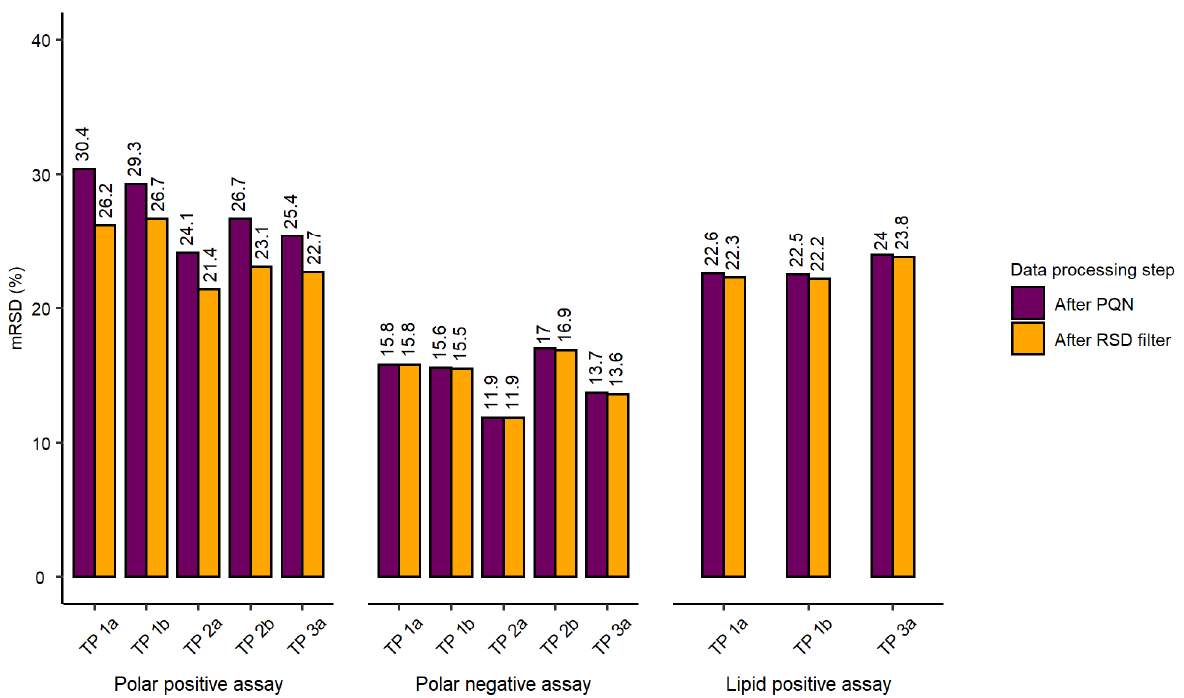
Figure 1. Results presented for all three nESI-DIMS assays (polar positive, polar negative and lipid positive) with 96-well microplates, labelled as “test plates” or “TP”, indicating the order of their extraction (1–3) and position on the instrument’s deck (a-b) following normalisation (termed “After PQN”), and filtering of variable features (termed “After RSD filter”). For each 96-well microplate, median relative standard deviation (mRSD (%)) of spectral feature intensities was calculated before and after the RSD filtering (i.e., removal) of spectral features for which the feature RSDs exceeded 30% in intrastudy QC samples. Table 2. Assessment of the automated in vitro metabolomics workflow’s repeatability based on a spectral feature putatively assigned to the internal standards: L-tryptophan-d 5 for polar metabolom- ics assays and dodecylphosphorylcholine-d 38 for the lipid assay ([M+H] + or [M-H] − for positive and negative ion modes, respectively) . P(+), P(-), L(+) correspond to polar positive, polar negative and